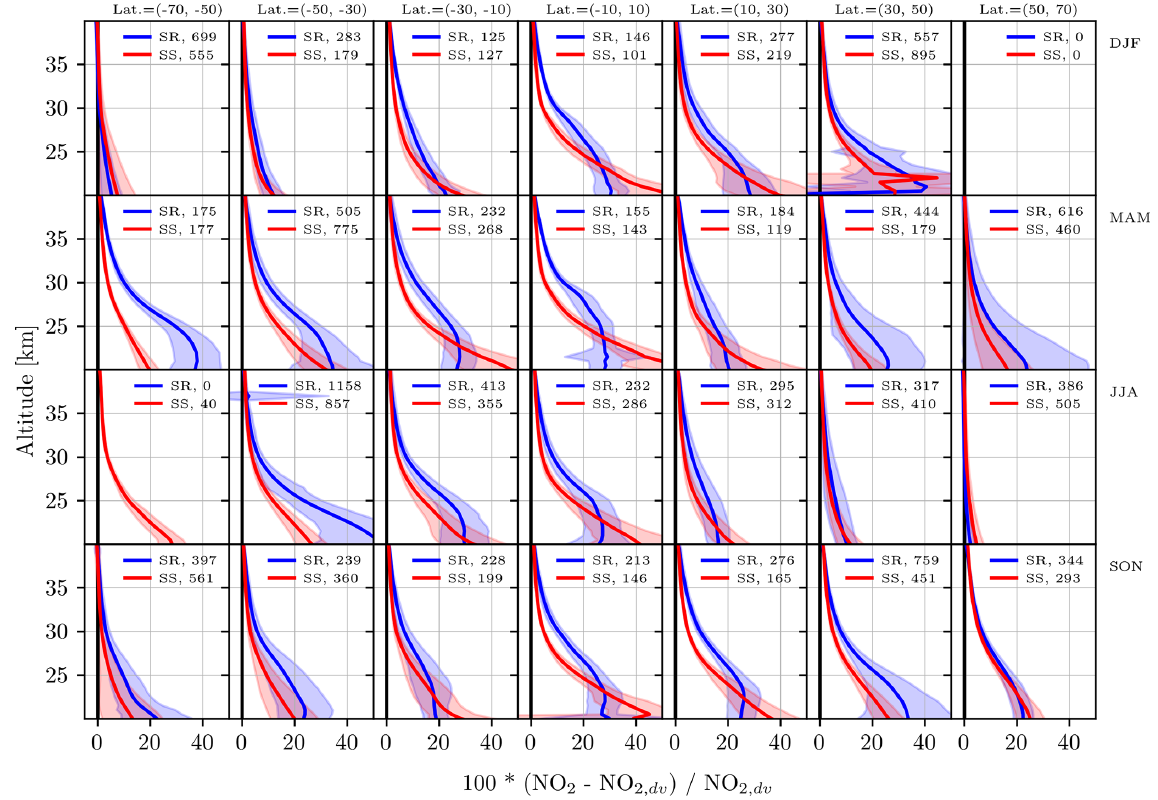
Figure 7. Mean difference between the SAGE v5.1 and diurnally varying (dv) retrievals for SAGE III/ISS sunset and sunrise NO 2 . The error bars are the standard deviation. NO 2 values more than 5 standard deviations from the mean are not included.